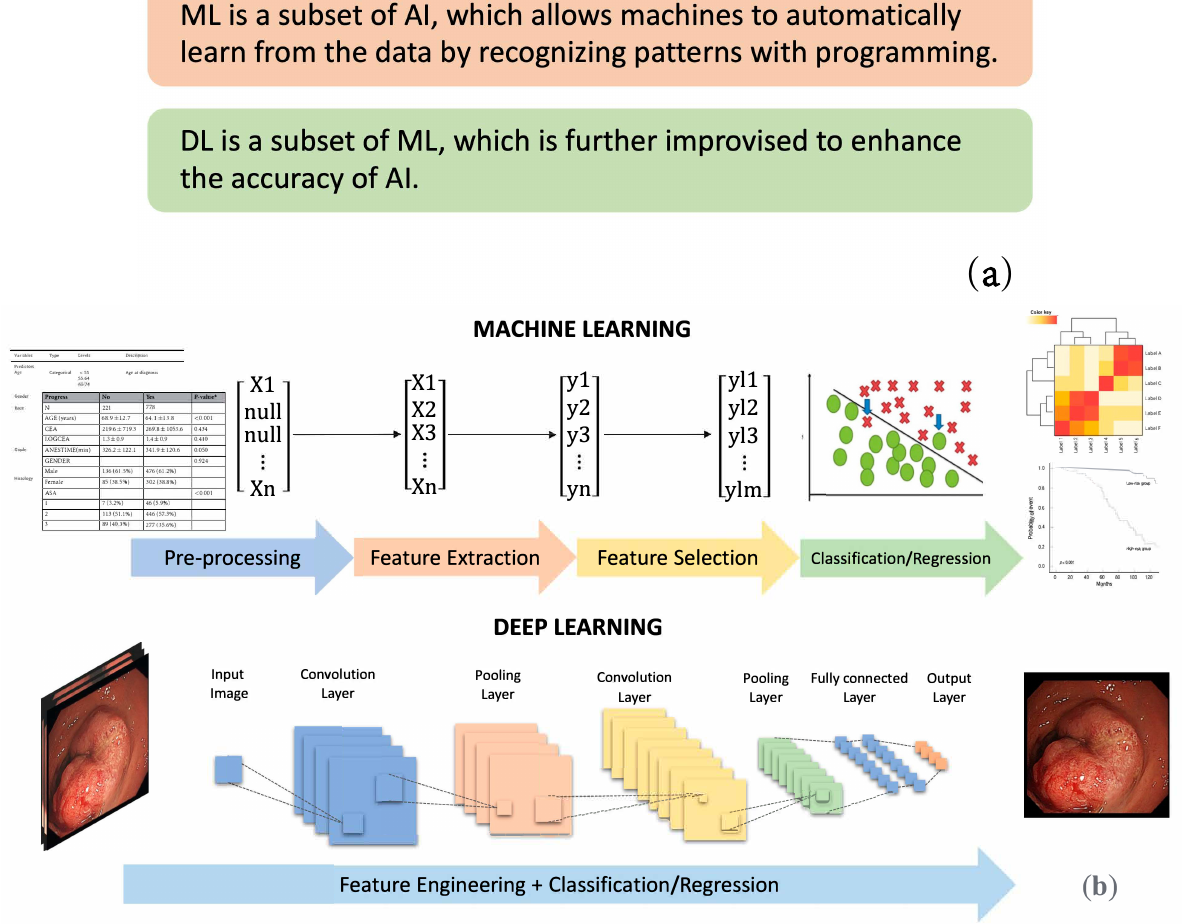
Figure 2. Basics concepts of AI, ML, and DL. ( a ) The relationships of AI, ML, and DL; ( b ) The workflows of ML and